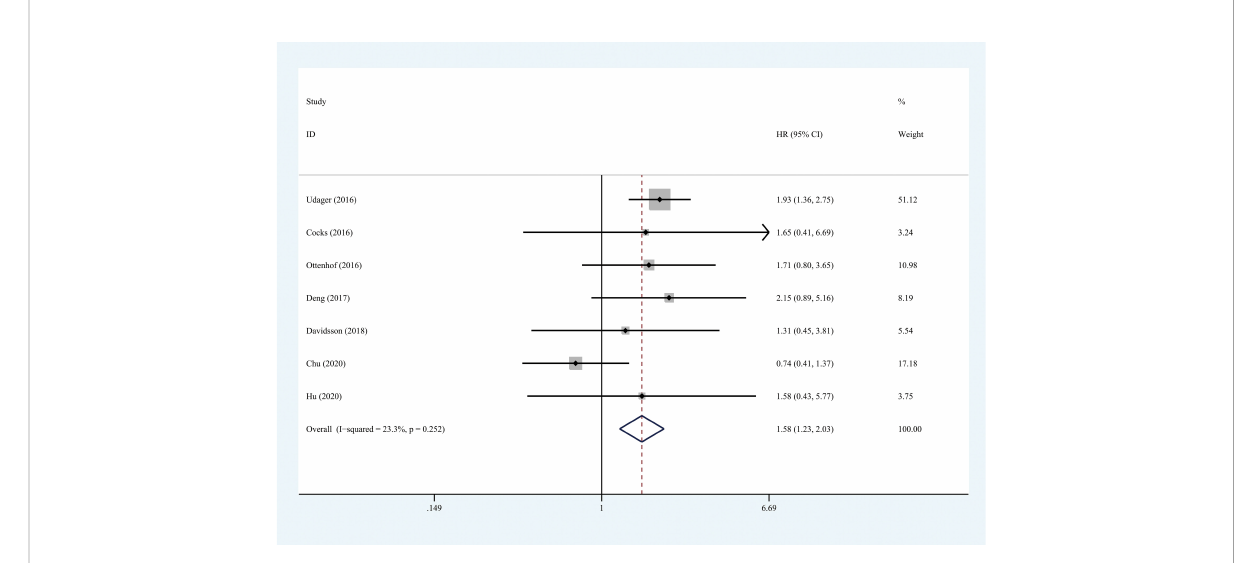
FIGURE 3 Prognostic value of PD-L1 for CSS. CSS, cancer speci fi c survival; HR, hazard ratio; CI, con fi dence interval.